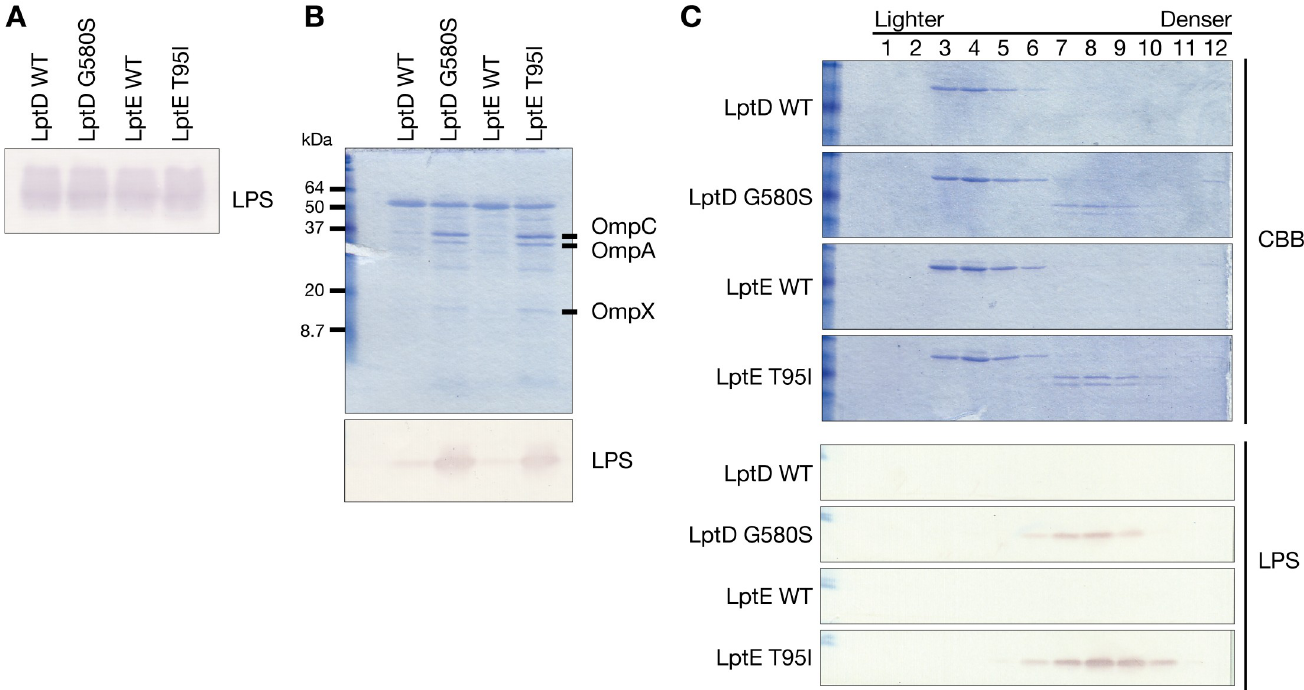
Fig 3. The LptD and LptE mutants increase production of OMVs. (A) Overnight cultured bacterial cells of the LptD WT, LptD G580S, LptE WT, and LptE T95I strains were lysed, electrophoresed in SDS-polyacrylamide gels, and subjected to Western blot analysis using an anti-LPS antibody. (B) Culture supernatants of the LptD WT, LptD G580S, LptE WT, and LptE T95I strains were ultracentrifuged and the precipitates were electrophoresed in SDS-polyacrylamide gels. The gels were stained by Coomassie Brilliant Blue (upper panel). Bands for OmpC, OmpA, and OmpX were identified by peptide mass fingerprinting analysis ( S2 Table ). The same samples were also subjected to Western blot analysis using an anti-LPS antibody (lower panel). (C) Culture supernatants of the LptD WT, LptD G580S, LptE WT, and LptE T95I strains were ultracentrifuged and the precipitates were further fractionated by density gradient centrifugation. The fractionated samples were electrophoresed in SDS-polyacrylamide gels and stained with Coomassie Brilliant Blue (upper panel). Also, the fractionated samples were subjected to Western blot analysis using an anti-LPS antibody (lower